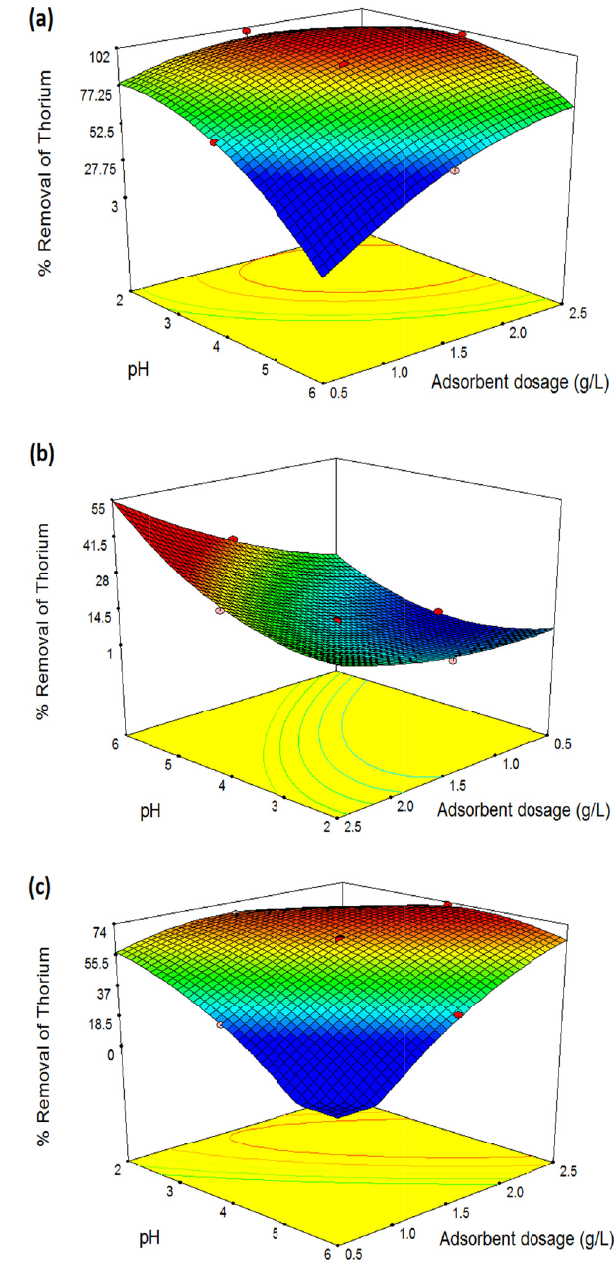
Fig. 1. Three-dimensional plots showing effect of initial Th(IV) ion concentration [mg.L -1 ] and pH on the removal efficiency of Th(IV) using IR-120 (a), IRA-400 (b) and in combination (c), keeping adsorbent dosage 1.5 g.L -1 .